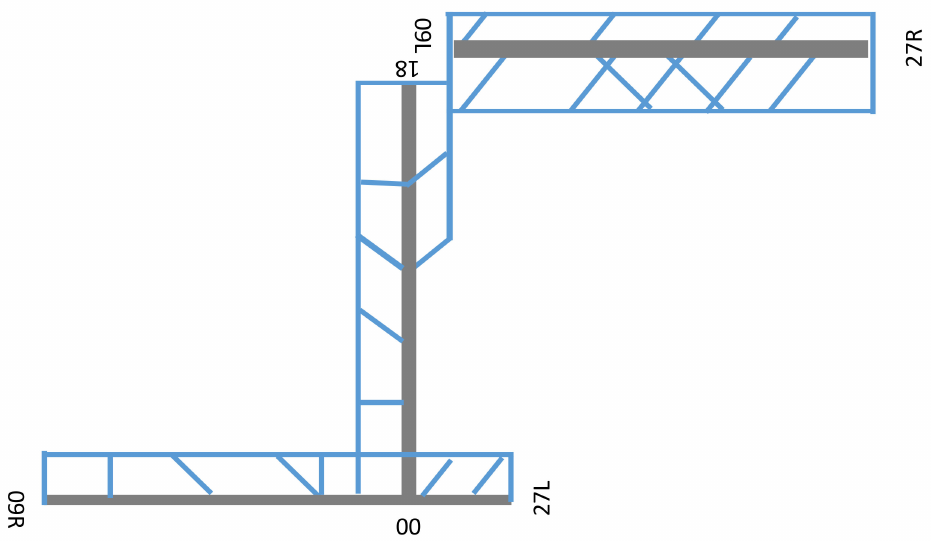
Figure 1. Airport Runways system.